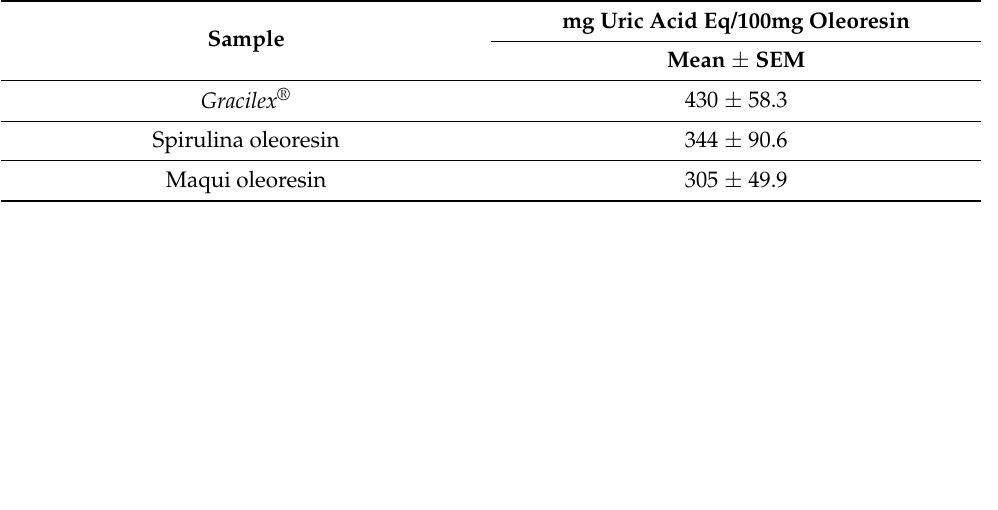
Table 2. Total antioxidant capacity of oily extracts derived from botanical sources measured with CUPRAC assay. Results were standardized using a uric acid curve according to the manufacturer’s instructions and expressed as equivalent of uric acid per 100 mg of oleoresin. Results are expressed as the mean of independent determinations ± SEM. Gracilex ® ( n = 7), spirulina oleoresin ( n = 3), and maqui oleoresin ( n =